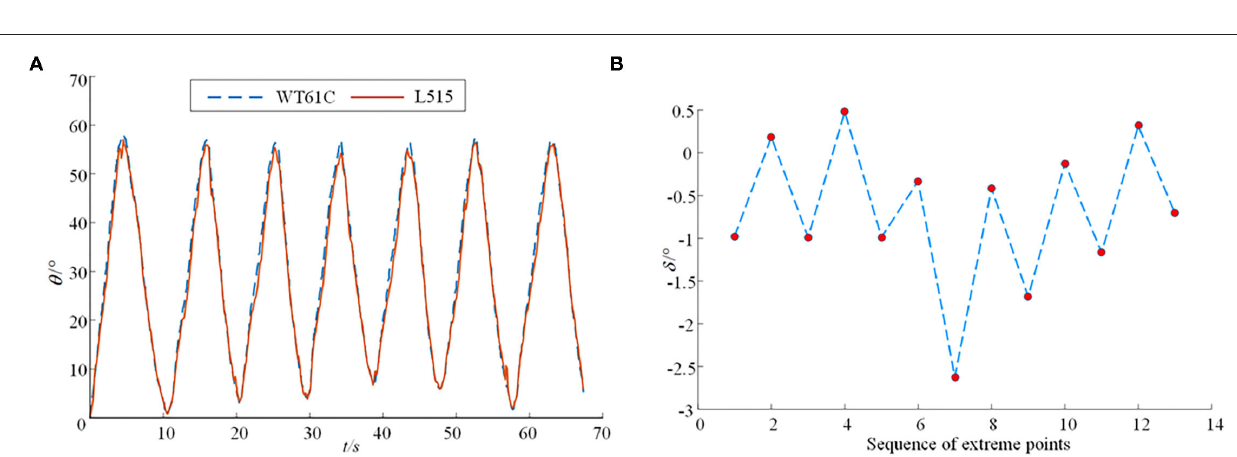
FIGURE 12 | The results from the joint range of motion detection system for the joints in the coronal plane. (A) The detection of motion angle in the coronal plane; (B) Error diagram between the control group and experiment group for comparison in the coronal